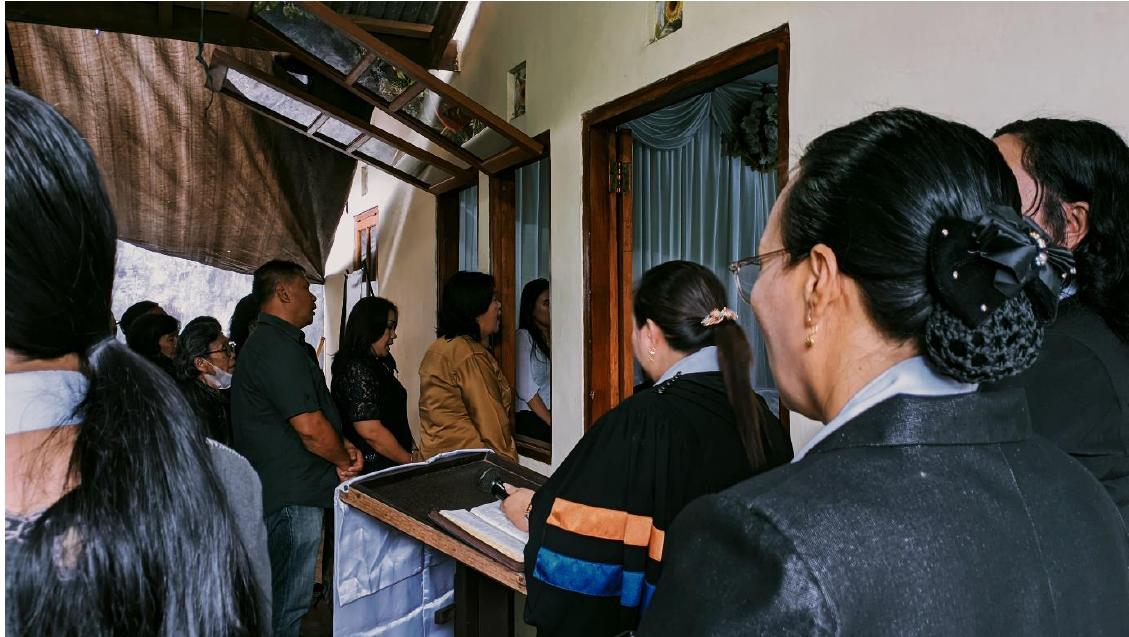
Fig 2. Members of the "Arisan Rukun" group are praying for one of the group members who passed away (Source: Researcher